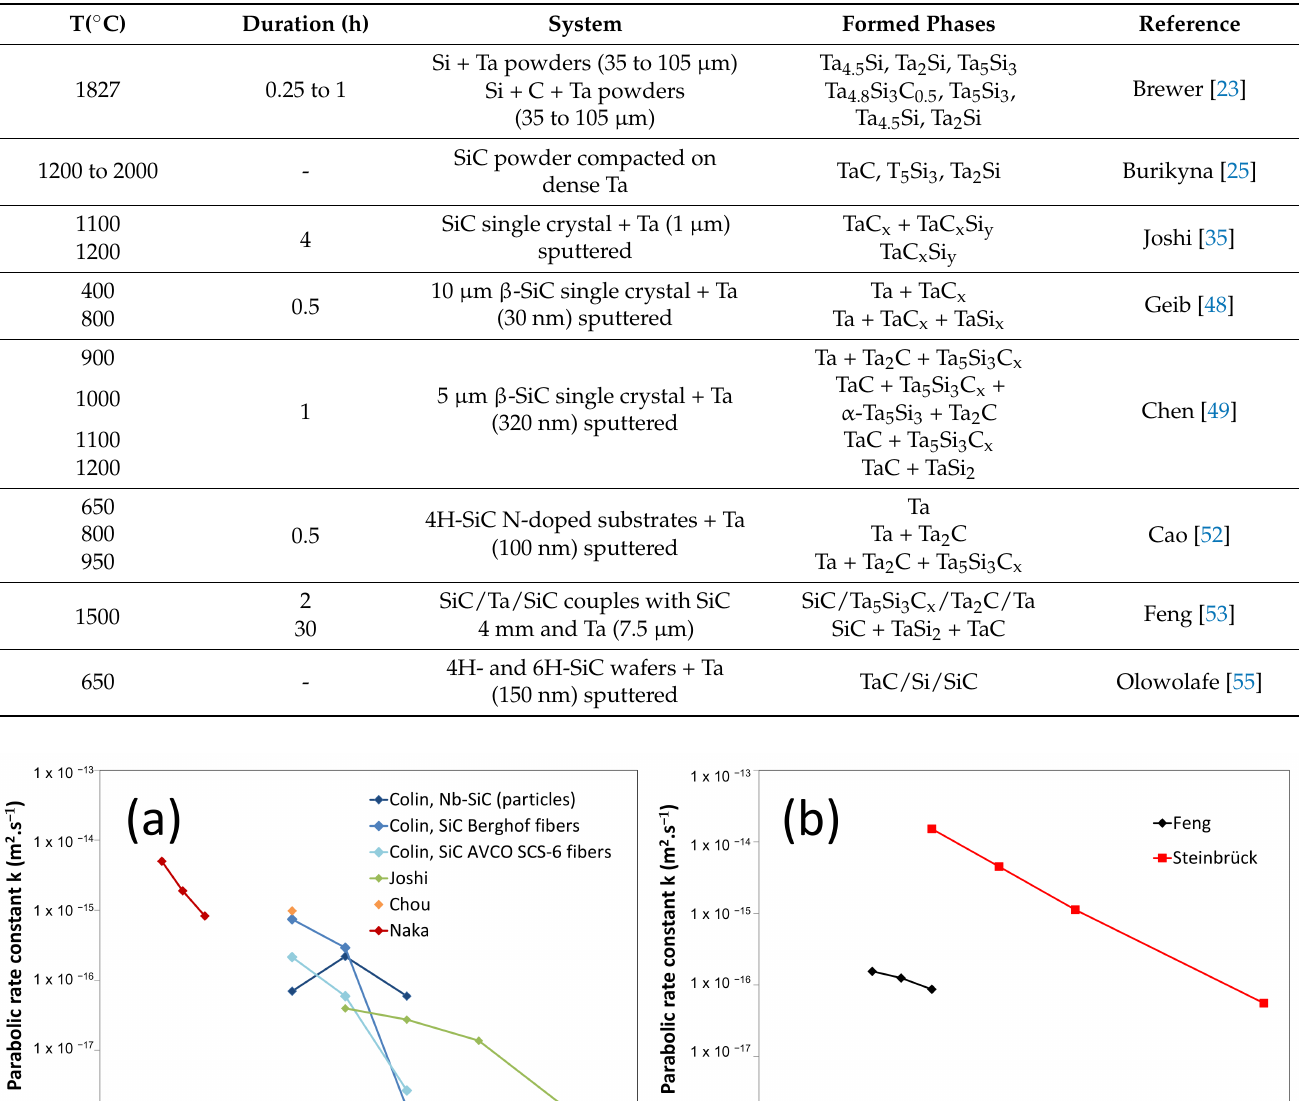
Table 2. Composition of the reaction zone as a function of the system and the annealing conditions in the Ta–Si–C system.